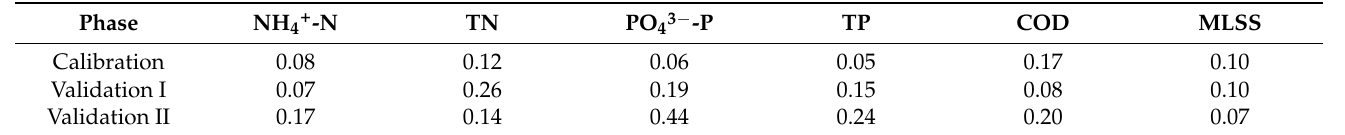
Table 3. The TIC values concerning effluent quality indexes and MLSS of the aerobic zone of ASM2d in the lab-scale AAO